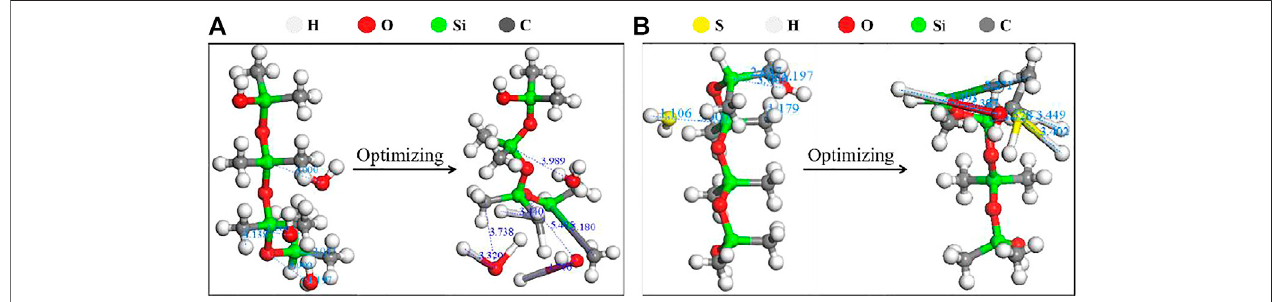
FIGURE 9 | Simulated geometric optimization results: (A) adsorption of H 2 O on PDMS; and (B) adsorption of H 2 O and H 2 S on